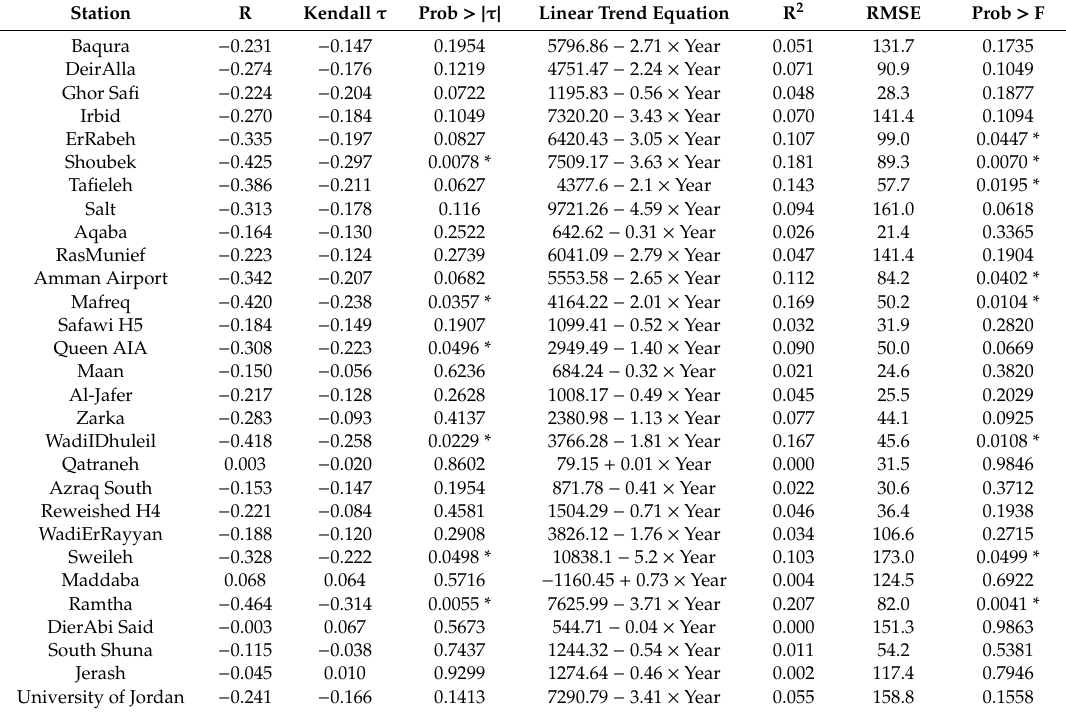
Table 2. Mann–Kendall test and linear regression trend results for the annual rainfall records per weather station.